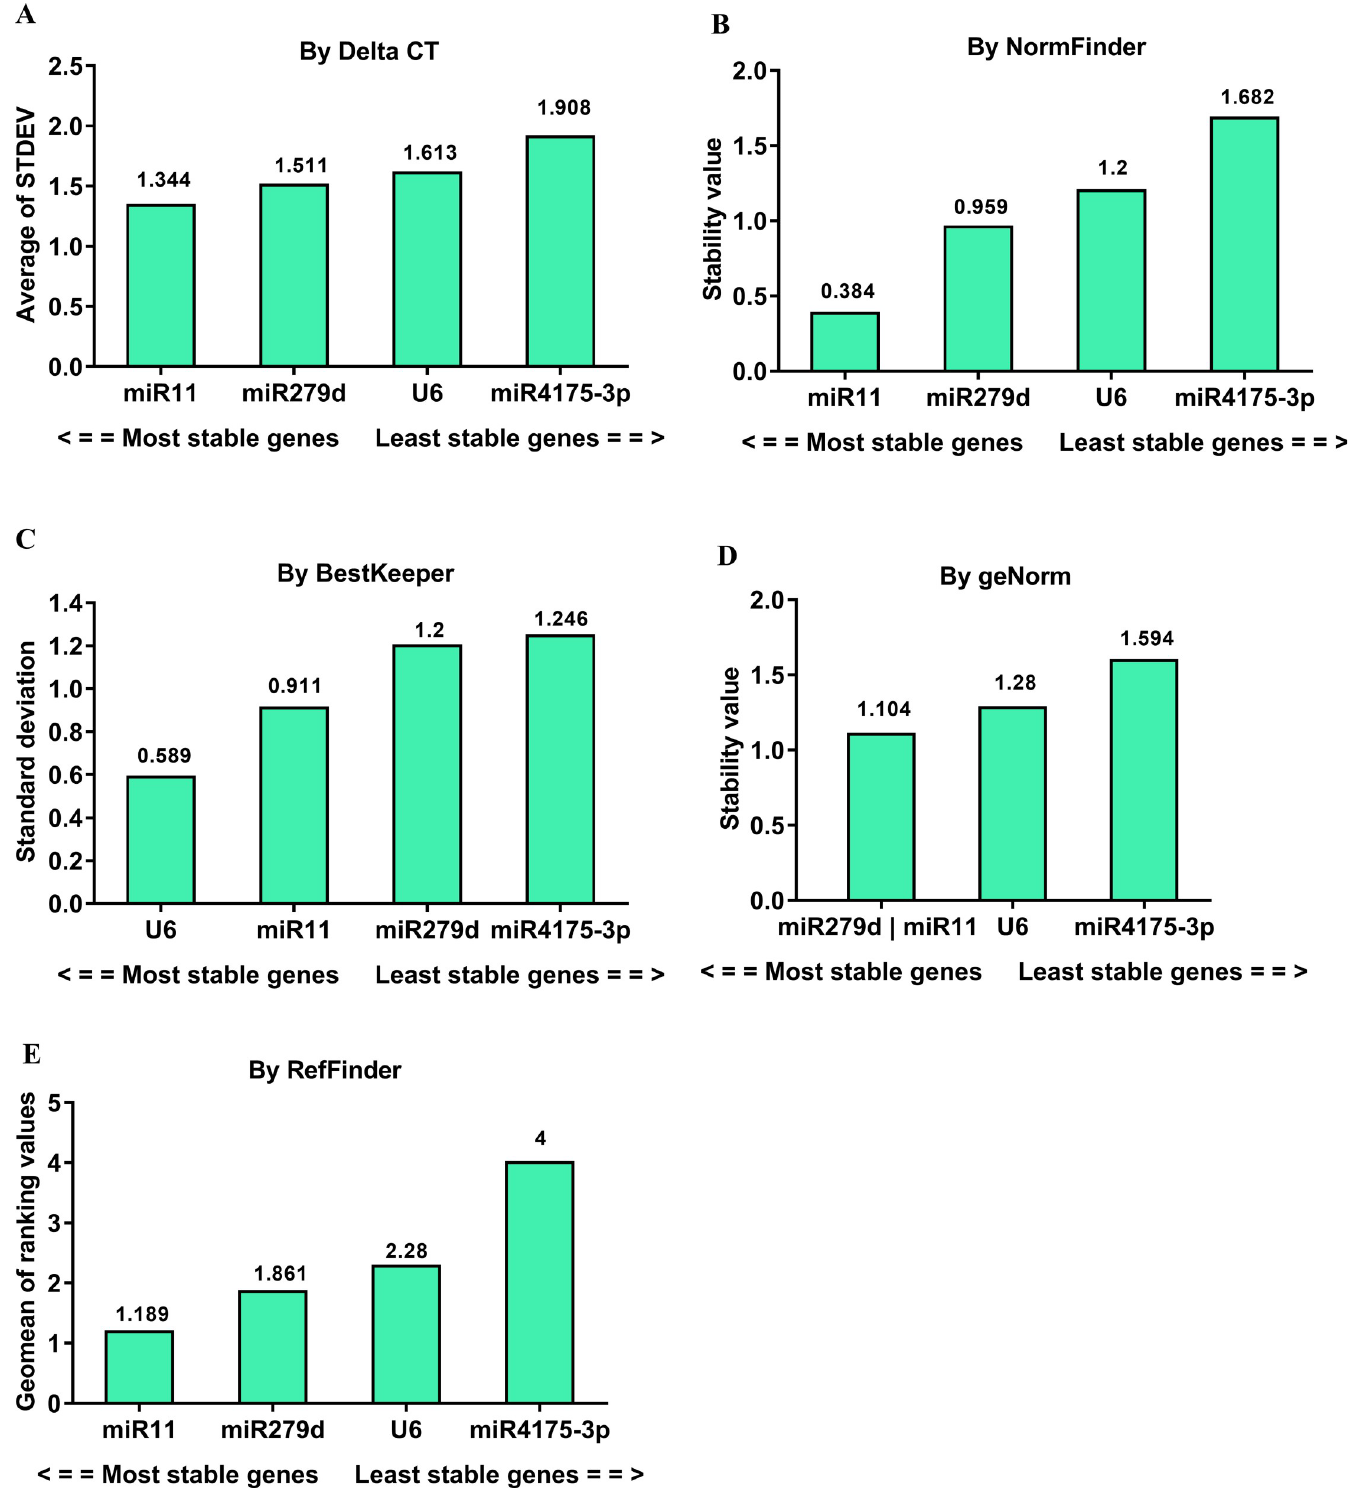
Fig 4. Stability analysis of the candidate reference genes in the tissues of GC strain. The Ct values derived from samples including midgut, silk gland, Malpighian tubule, fat body, hemolymph and remaining tissues from the first-day 4 th instar larvae were used to calculate the stability values by different algorithms. A lower value indicates a more stable candidate gene as reference gene (numbers reported above the